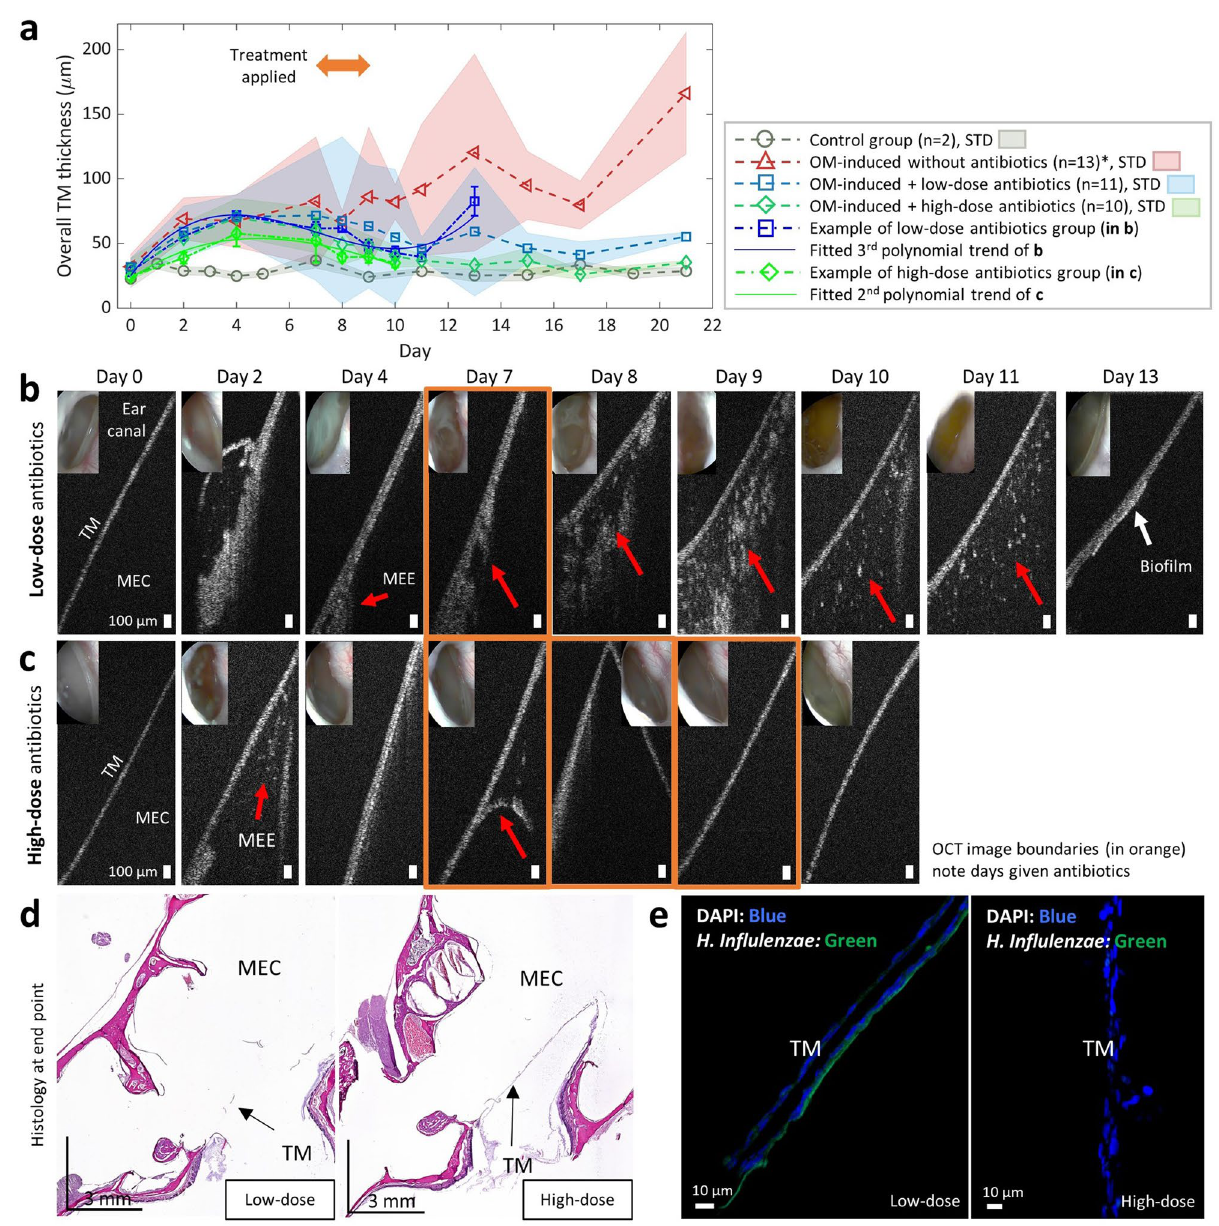
Figure 5. Clearance of MEE after antibiotic therapy longitudinally observed with OCT. ( a ) Plot of the averaged TM thickness and standard deviation in the control, OM-induced without antibiotics, OM-induced with low-dose and high-dose antibiotics groups, where n indicates the number of animals. Note that animals longitudinally tracked for longer than day 3 post-inoculation are included in the plot. Plots from the representative animals in ( b ) and ( c ) are shown in solid blue and green lines, respectively. OCT and otoscopy (inset) images of AOM-induced chinchillas in ( b ) low-dose and ( c ) high-dose antibiotic treatment groups. In ( b ), OCT revealed the absence of MEE and the presence of an additional scattering layer affixed to the TM (white arrow) on day 13. In ( c ), a chinchilla receiving high-dose treatment displayed resolution of OM with no MEE detected on and after day 9. Scale bars in OCT represent 100 µm. ( d ) Histologic images of ( b ) and ( c ) on day 13 and day 10, respectively. ( e ) Confocal laser scanning microscope images from fluorescence in situ hybridization (FISH). A nuclei stain (DAPI) detects unspecified genetic components, whereas the green fluorescence indicates the presence of NTHi on the TM. *Animals in the OM-induced without antibiotics group from Fig. 3b are also included. Three animals in the infected without antibiotics group spontaneously healed and were not included in the plot in ( a ). STD standard